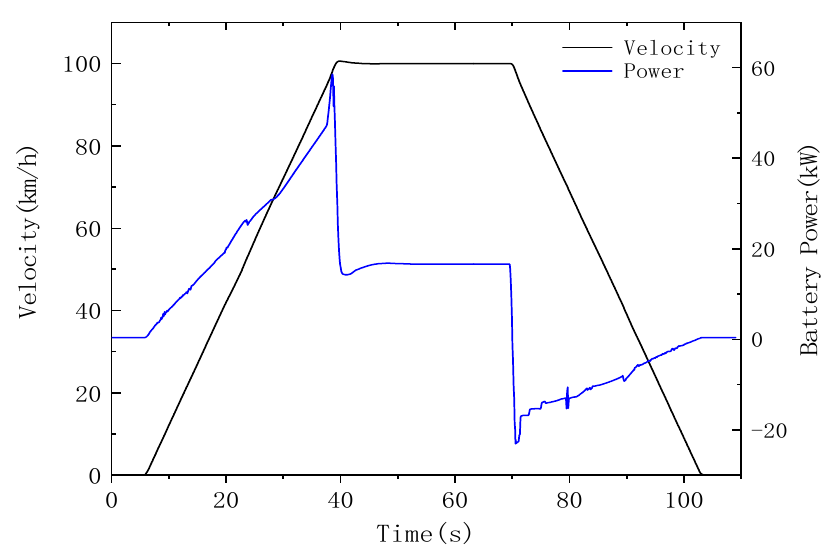
Figure 9. Changes in battery output power of BEV under 0–100 km / h acceleration condition.